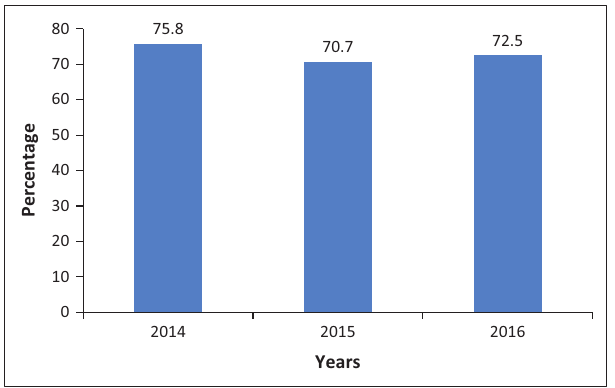
FIGURE 1: Three Year National Performance